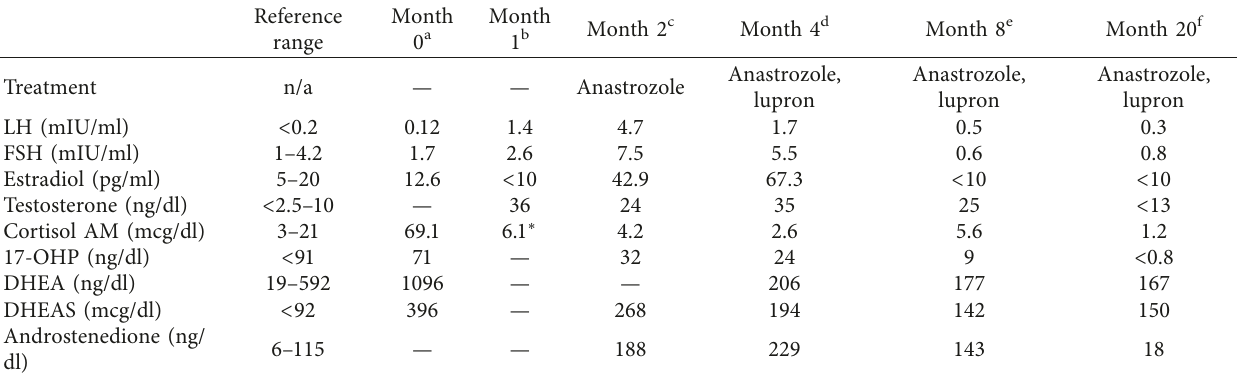
Table 1: Laboratory test results and medication dose at different time